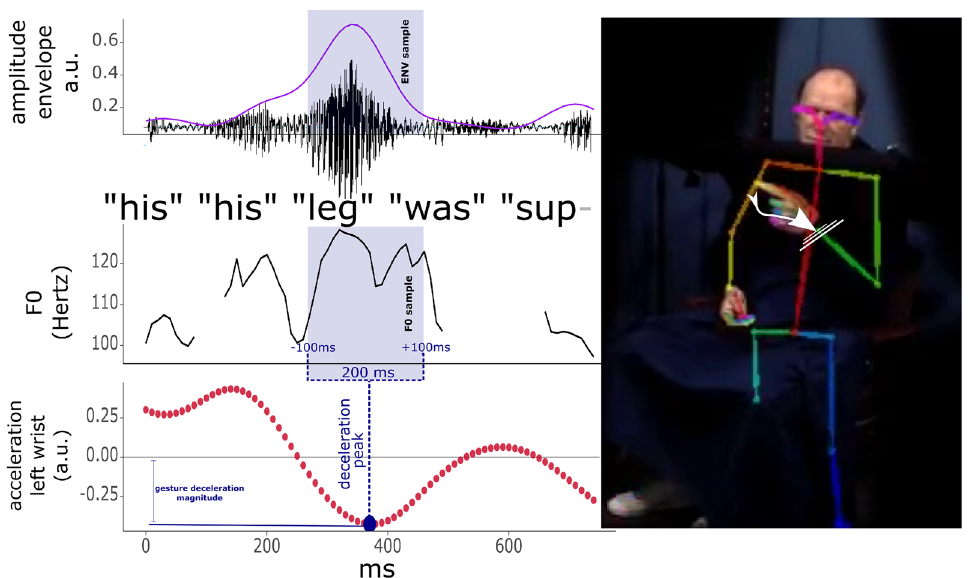
Figure 3. Physical impulse and acoustic analyses example. Note . Example of a gesture produced by IW under the blind during the 2002 retelling of the “snow business” cartoon. IW produces a gesture to signify the leg of Sylvester serving as the beam of a rotisserie. This gesture traces out the rotisseries structure but also has a quite sudden halt or peak in deceleration. This gesture’s deceleration rate was in the high impact range as compared to the other observed deceleration rates in the current data. For our physical impulse analyses, the peak deceleration was determined and then within a 200 ms interval F0, amplitude envelope (in purple), and head displacement values (not shown here) were sampled around that point. We would expect more extreme decelerations (higher impulse gestures) would coincide with observations of F0 and the amplitude